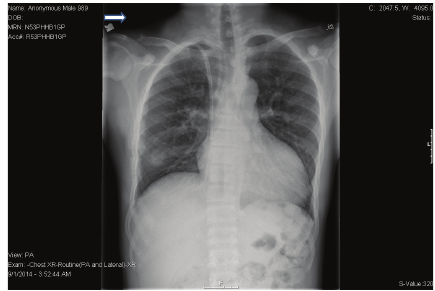
Figure 9: Bone resorption of the lateral ends of both clavicles (denoted by